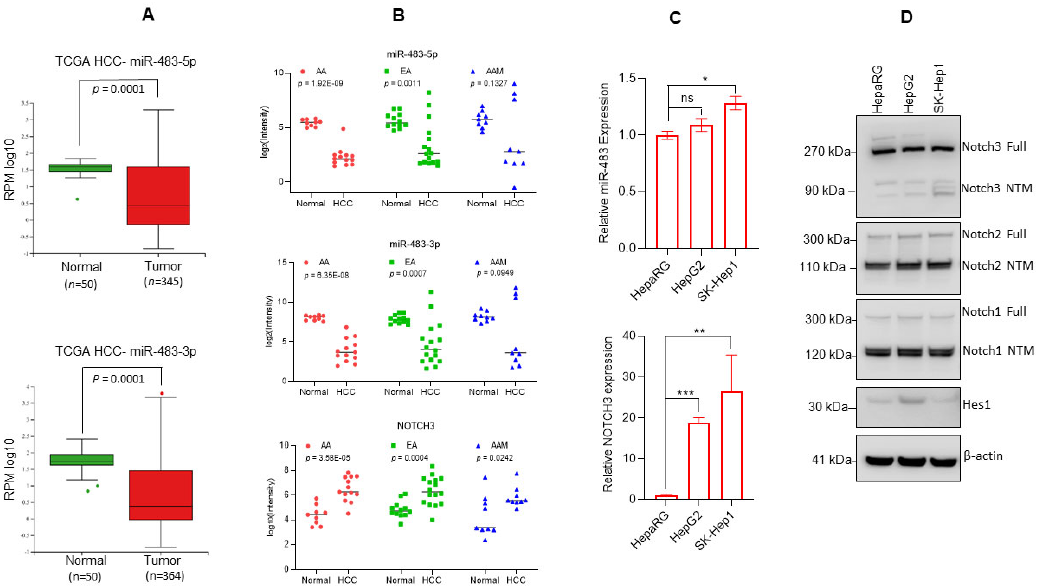
Figure 1. Downregulation of miR-483 in HCC. ( A , upper and lower panels ): Expression of miR-483-5p and miR-483-3p as reported in The Cancer Genome Atlas Liver Hepatocellular Carcinoma (TCGA-LIHC) data set is presented (MIR-TV: http://mirtv.ibms.sinica.edu.tw/analysis.php, accessed on 9 August 2022). p = 0.0001 compared with normal liver tissues. ( B ) Expression of mir-483-5p, miR-483-3p, and Notch 3 in HCC patient tumors of African American (AA), European American (EA), and Asian American (AAM) was analyzed by RNAseq. p values are presented in the graphs compared with normal HCC tissues ( Upper, middle, and lower panels ). ( C ) Endogenous expression of miR-483-5p and Notch 3 in HepaRG and HCC cells was determined by RT/qPCR. * p < 0.05, ** p < 0.01, *** p < 0.001 compared to HepaRG cells. ns: not significant. ( D ) Cell lysates of HepaRG, HepG2, and SK-Hep1 cells were immunoblotted with anti-Notch 3, anti-Notch 2, anti-Notch 1, Hes1, and β -actin antibodies. The uncropped blots are shown in Supplementary